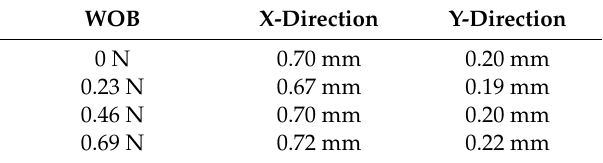
Table 11. Lateral displacement of BHA under different WOB in experiment.